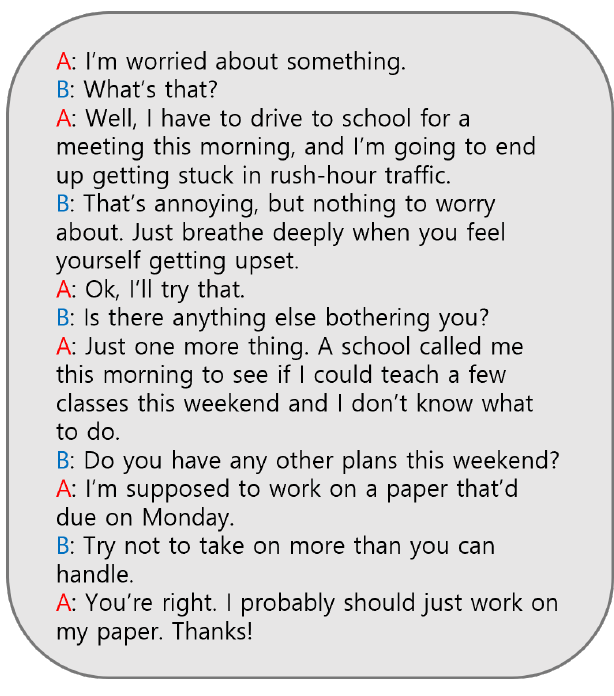
Figure 4. A continuous dyadic conversation.